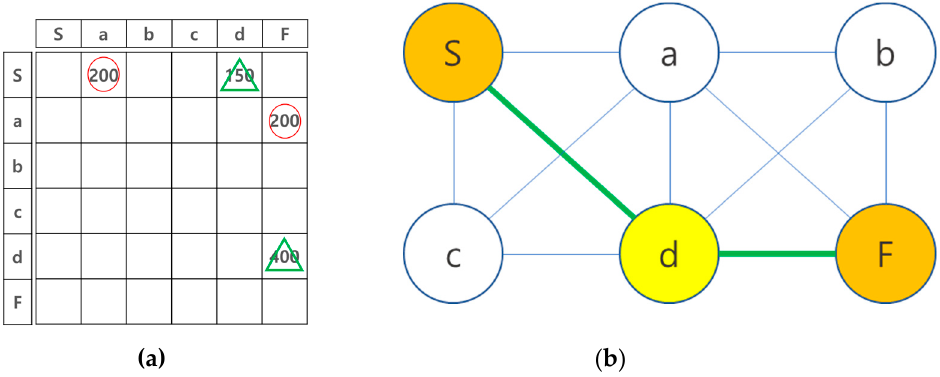
Figure 9. ( a ) Number of tie points in the two shortest paths and ( b ) selected optimal path from S to F (green line).